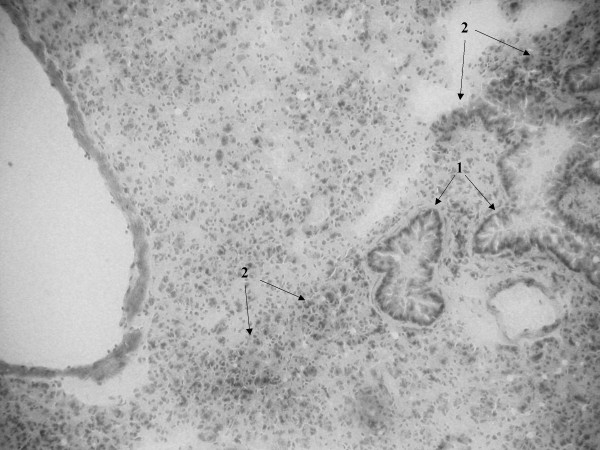
Light microscopy of lung tissue from mice infected with 106CFU of S. pneumoniae. SP-D-/- 24 h post-infection (figure 5), SP-D+/+ 24 h post-infection (figure 6), SP-D-/- 48 h post-infection (figure 7) and SP-D+/+ 48 h post-infection (figure 8). Magnification ×250 for figures 5 and 8, ×400 for figures 6 and 7. See results for description of arrows.